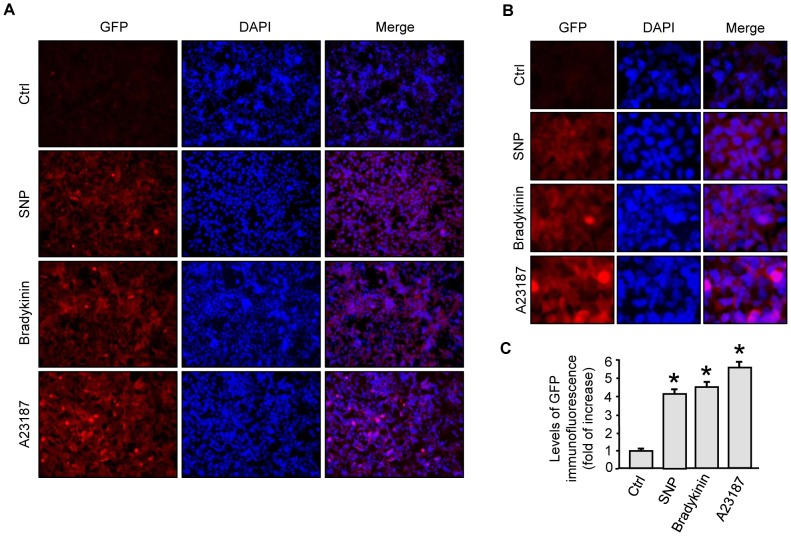
NO enhances the immunological staining of the 26S proteasome reporter proteins in endothelial cells.UbG76V-GFP-expressing HUVEC were respectively treated with control (vehicle buffer), SNP, Bradykinin, and A23187 for 1h and subjected to immunofluorescent staining with a commercial immune-staining kit including ProLong Gold and SlowFade Gold Antifade for GFP (with a primary anti-GFP antibody) or DAPI and a secondary antibody conjugated with a red fluorescent dye, Alex Fluor 594 at (A) low and (B) high-power fields of the same slides. All images shown are representative of three independent experiments. (C) Quantification results of (B). * represent p<0.05 vs control (n = 3). Ctrl, control; DAPI, 4′,6-diamidino-2-phenylindole; SNP, sodium nitroprusside; Ub-GFP, ubiquitin-green fluorescent protein.